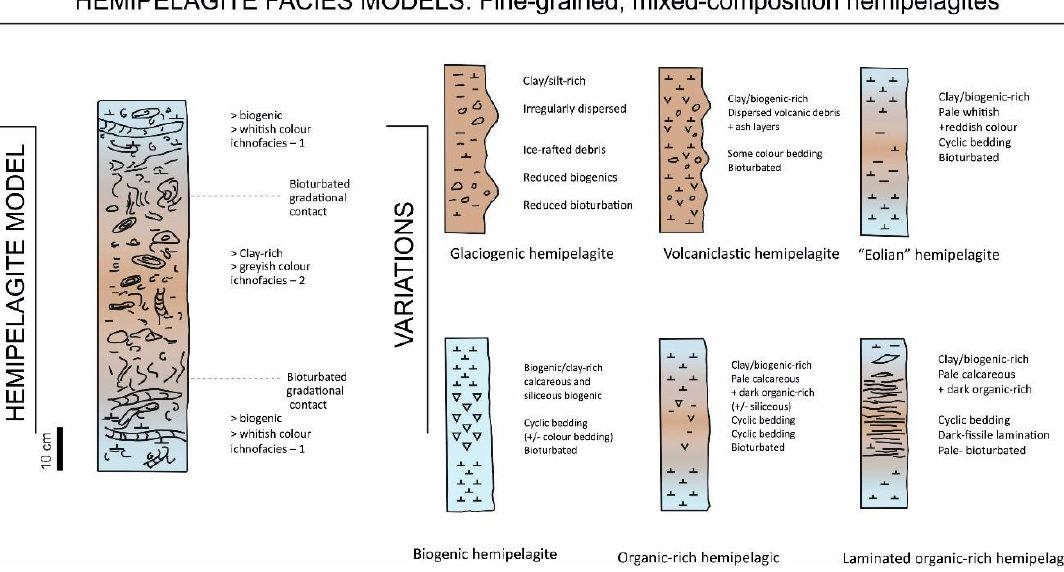
Figure 17. Hemipelagite facies models. The standard model shows simple compositional cyclicity between more clay-rich and more biogenic-rich parts. Variations depend on the input of different components.